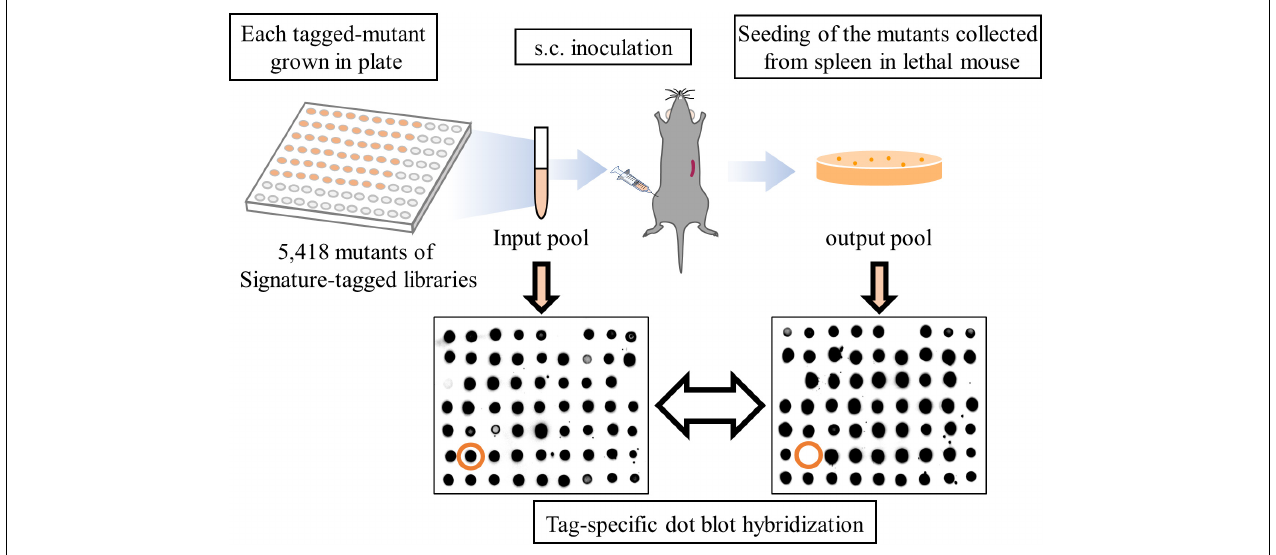
FIGURE 1 | Scheme of STM application to a murine model of V. vulnificus wound infection. A result of tag-specific dot blot hybridization for the input pool and output pool following a round of STM. Orange circles indicate tags detected in the input pool but not in the output